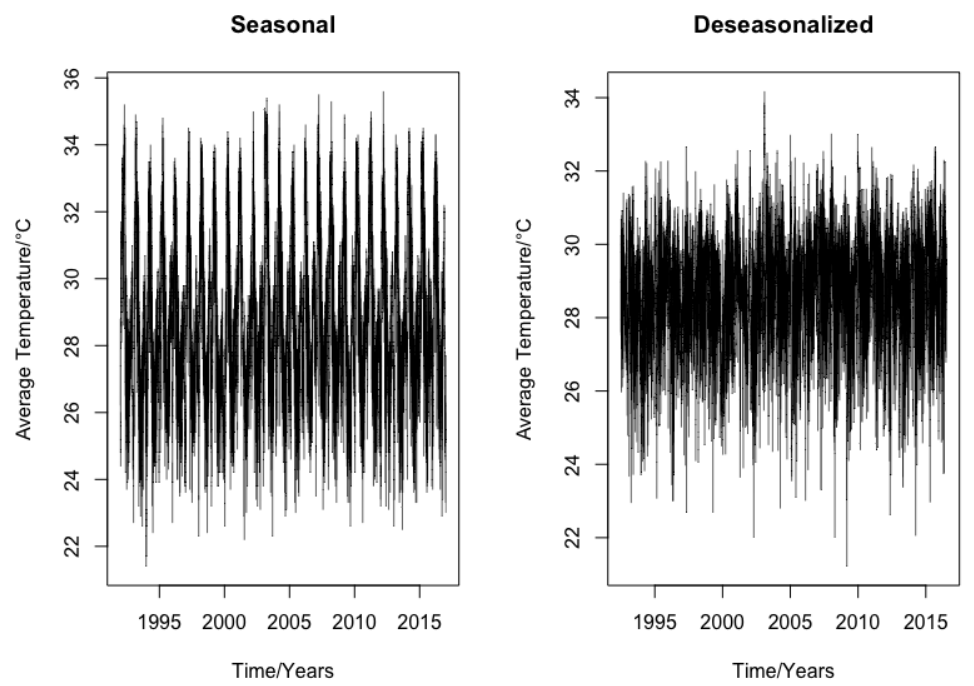
Figure 2. Seasonal and de-seasonalized daily average temperature of